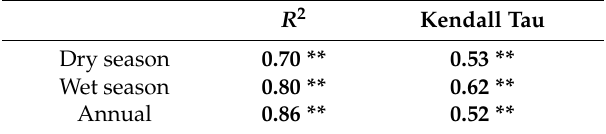
Table 8. Statistical tests of LAI in the study watershed and Jianfengling National Forest